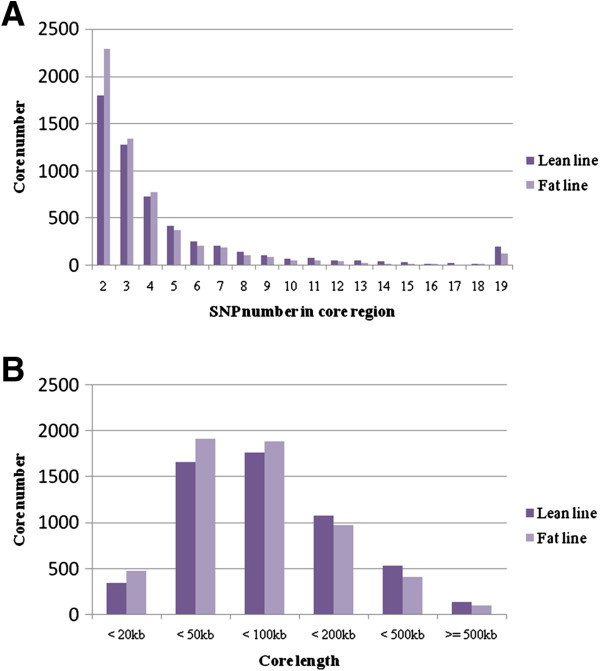
Distribution of SNP numbers in the core regions (A) and the length of core regions (B) in lean and fat lines.